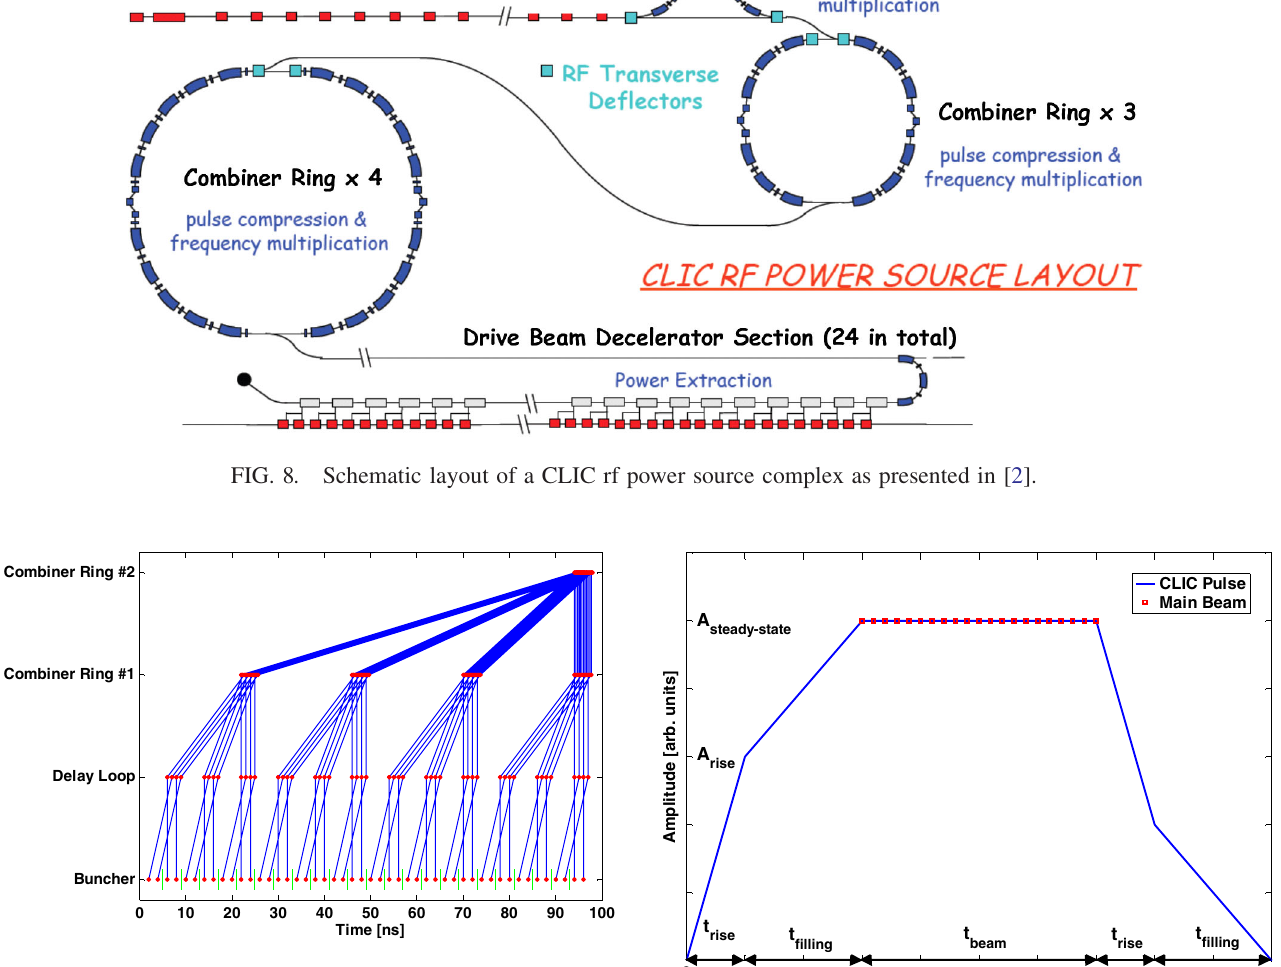
FIG. 9. CLIC drive beam combination scheme where 24 (cid:2) 4ns 0.5 GHz trains are combined into 1 (cid:2) 4 ns 12 GHz trains.